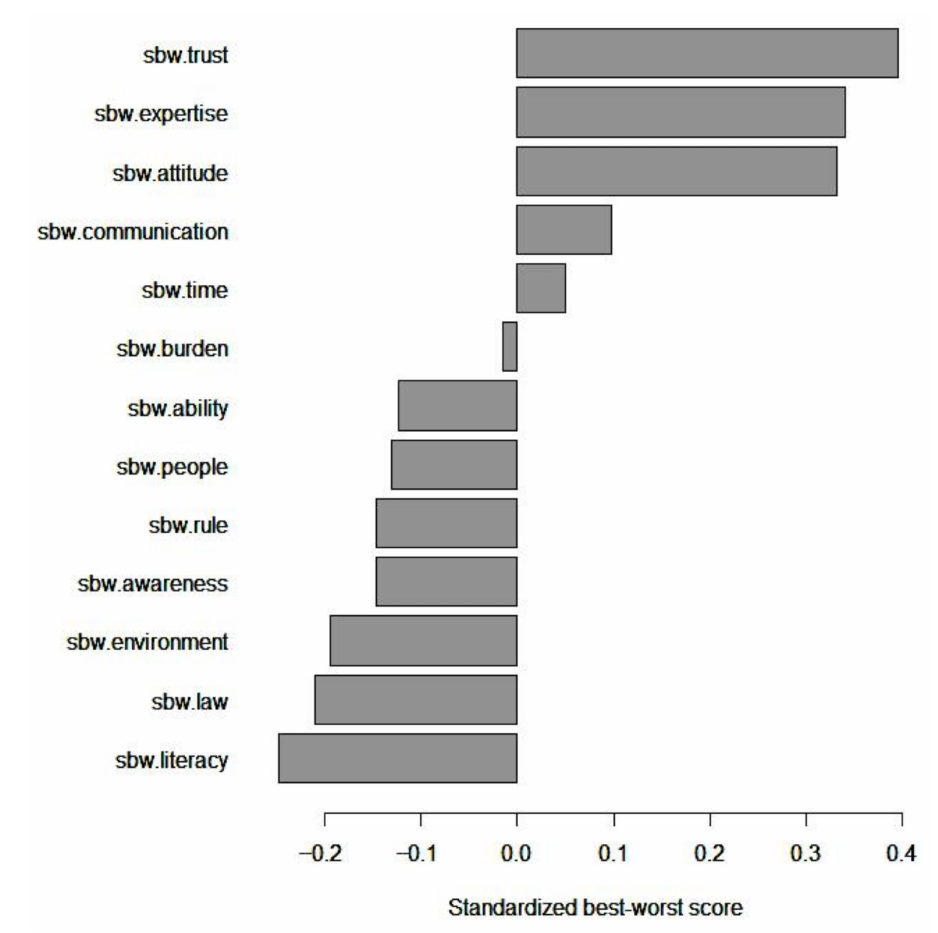
Figure 2. Bar plot of mean standardized best-worst